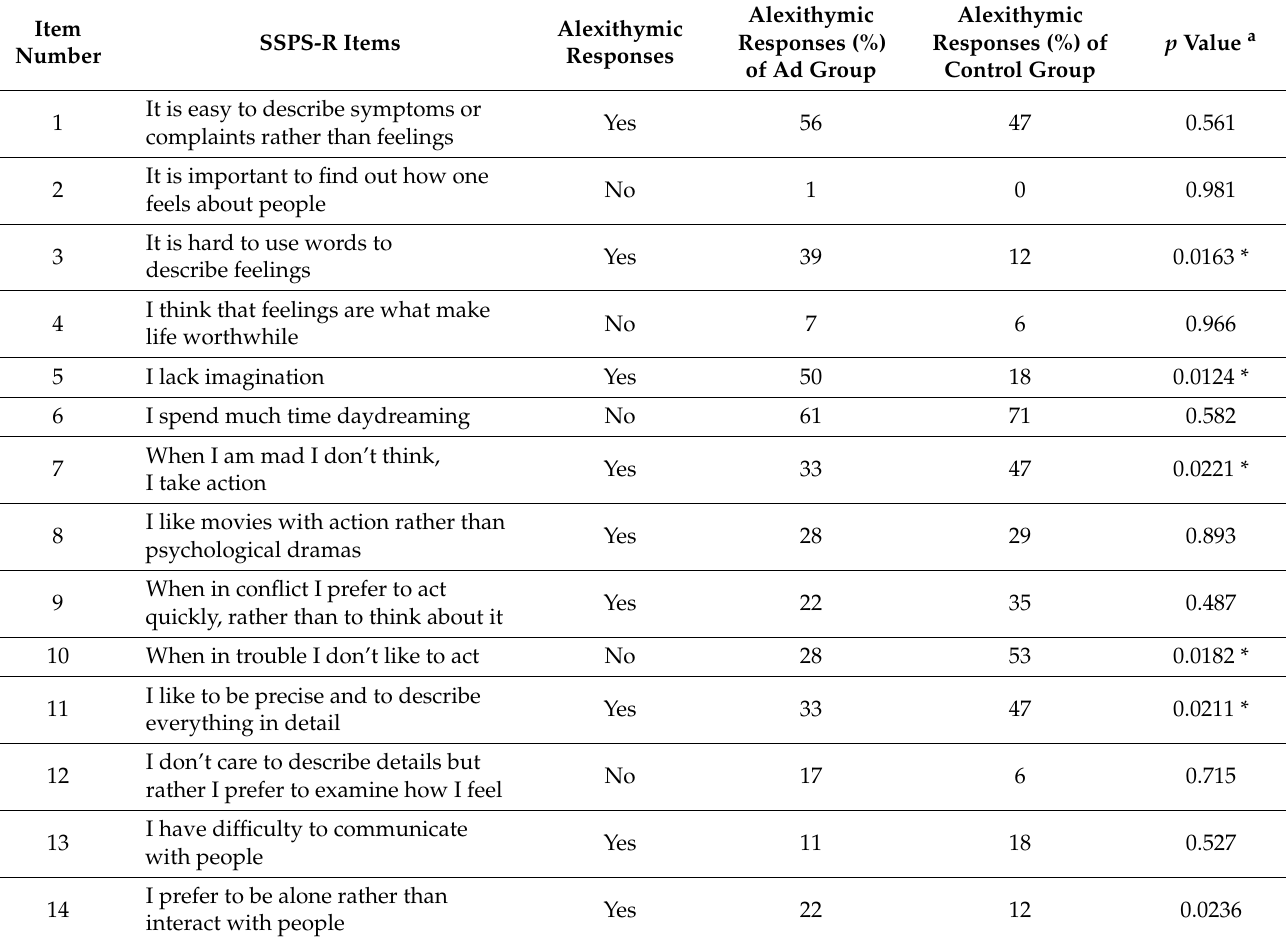
Table 4. Comparison of alexithymic responses (%) in each Shalling Sifneos Psychosomatic Scale (SSPS-R) item between the AD and control